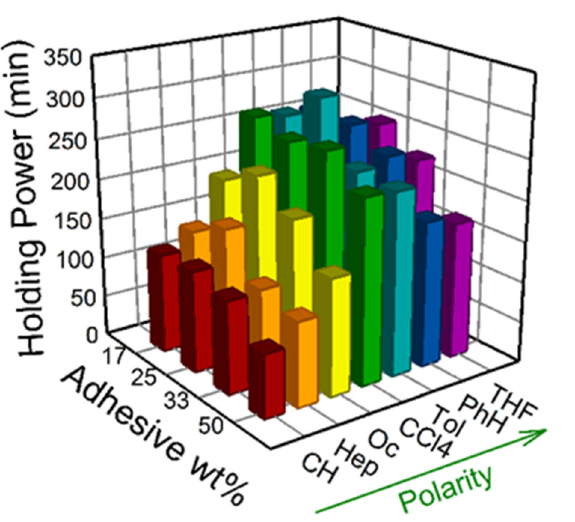
Figure 5. Holding power (average values) tested with different types of solvents and different adhesive weight percent in the prepared solutions.